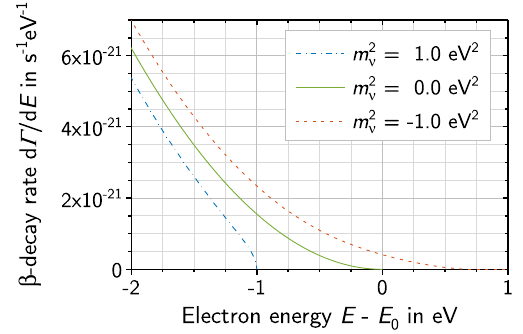
Fig. 22 Extrapolation of the differential β spectrum model for differ- ent values of the measured neutrino mass squared, including an non- (cid:22) m 2 ν = − 1 eV 2 (dashed red line) physical value of (cid:20) − m 2 < 0 and μ = 0 for m 2 > 0 (see 2 with μ = k ν for m ν ν Fig. 22). The factor k ≈ 0 . 72 is adjusted based on numerical calculations to make the χ 2 ( m 2 ν ) function (and negative log- likelihood respectively) symmetric around its minimum. A similar extrapolation scheme was used in the analysis of the Mainz and Troitsk neutrino mass experiments